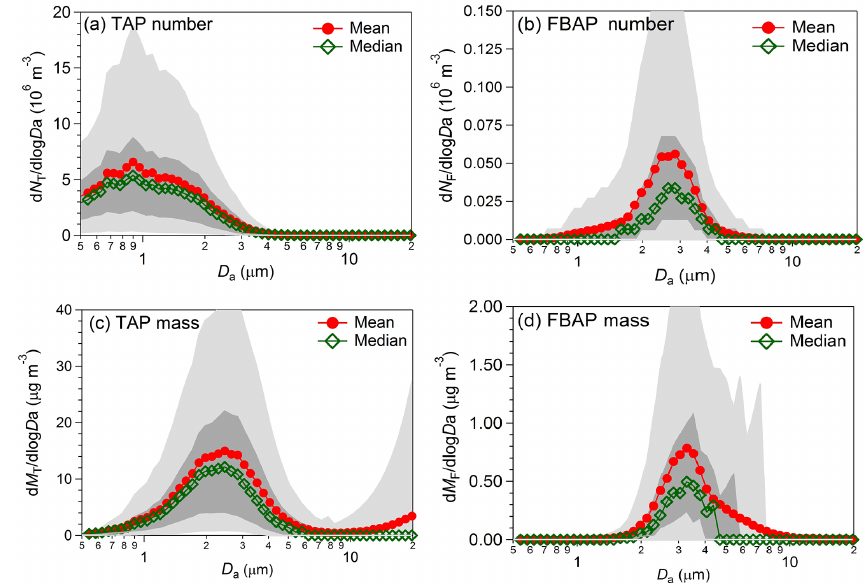
Figure 5. Particle number size and unit-normalized number size and mass size distributions averaged over the entire measurement campaign carried out at Munnar. The lower and upper parts of the dark and light shaded areas represent the 5th, 25th, 75th, and 95th percentiles, respectively. (a) TAP number (d N T / dlog D a ) , (b) FBAP number (d N F / dlog D a ) , (c) total mass (d M T / dlog D a ) , and (d) FBAP mass (d M F / dlog D a ) . Table 3. Comparison with other online measurements carried out under various environmental conditions across the globe. Slno.: Location Landuse Measurementperiod Season Instrument FBAPnumber Totalnumber Number Reference concentration concentration